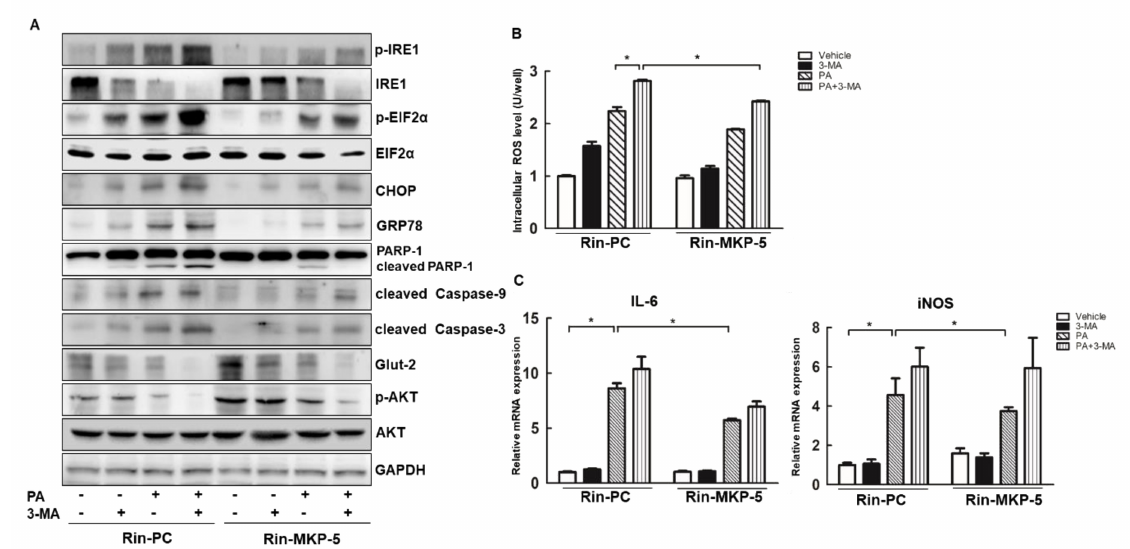
Figure 8. MKP-5 regulates PA-induced autophagy in Rin-m5f cells. ( A ) The levels of ERS-, apoptosis-, dysfunction-, and functional-related proteins in Rin-PC and Rin-MKP-5 cells treated with PA and 3-MA for 12 h were measured by Western blotting. ( B ) Levels of 3-MA and PA-induced intracellular ROS in Rin-PC and Rin-MKP-5 cells were determined using a fluorescence microplate reader by measuring DCFH-DA-fluorescence. ( C ) Expression of the inflammation-related genes iNOS, IL-6, and MCP-1 were detected by real-time PCR in Rin-m5f cells following PA and 3-MA exposure for 9 h. *, p < 0.05, EtOH vs. PA; Rin-PC vs.